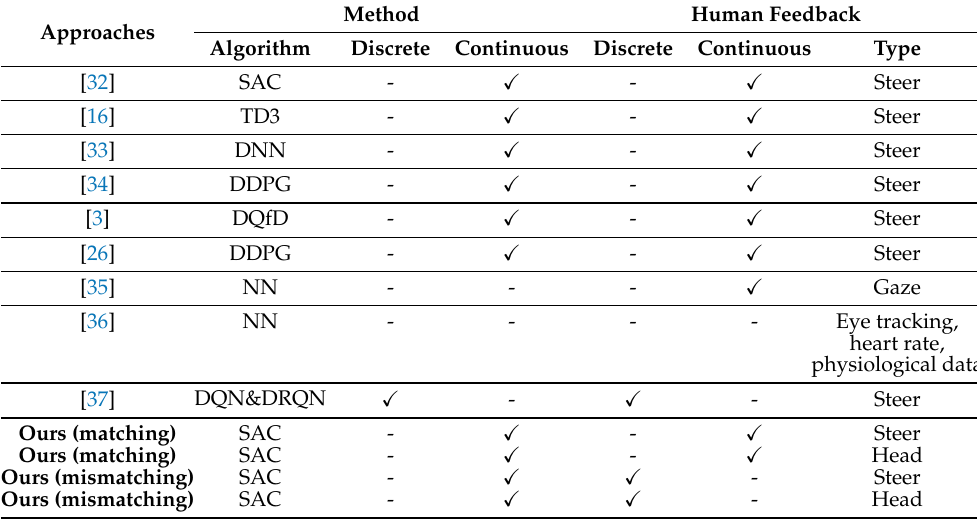
Table 1. Our contribution compared to existing